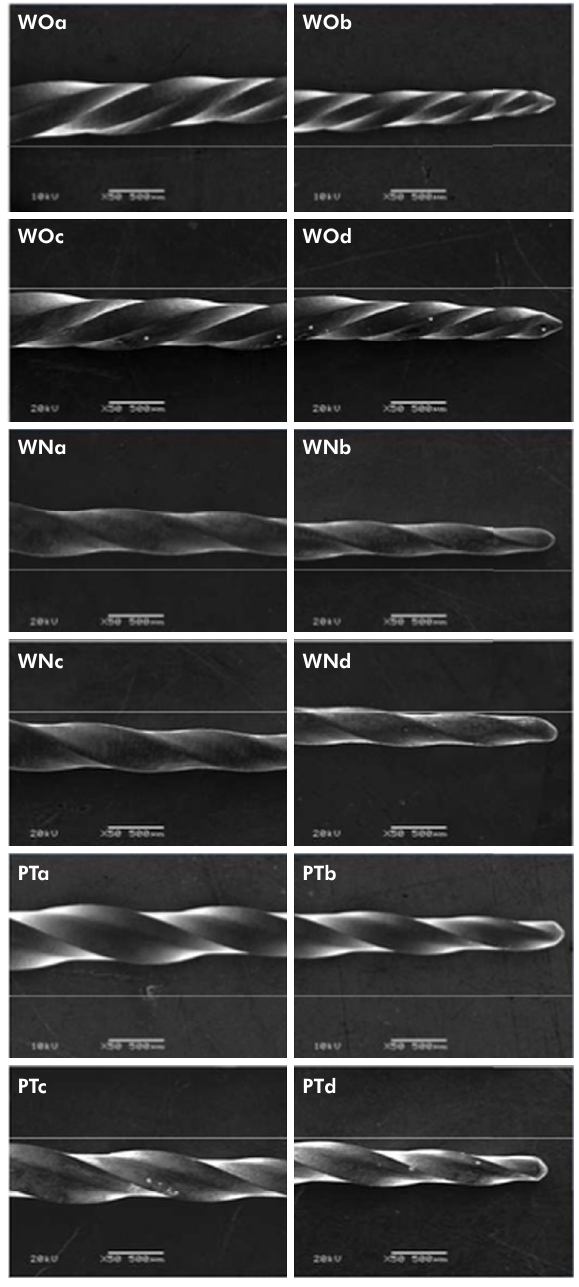
*indicates areas with defects along the examined shaft. Figure 4. SEM images showing WaveOne (WO), Wizard Navigator (WN) and ProTaper (PT) instruments before (a, b) and after (c, d) root canal instrumentation.